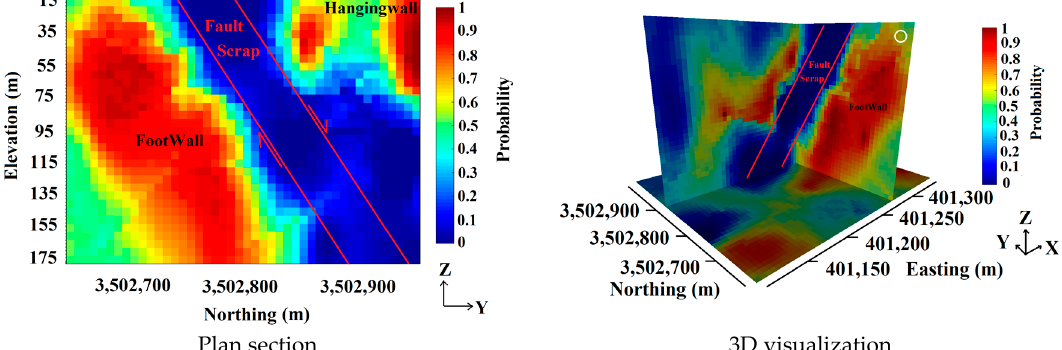
Figure 13. Possible detection of faulted region in the study area (section; Easting: 401299).